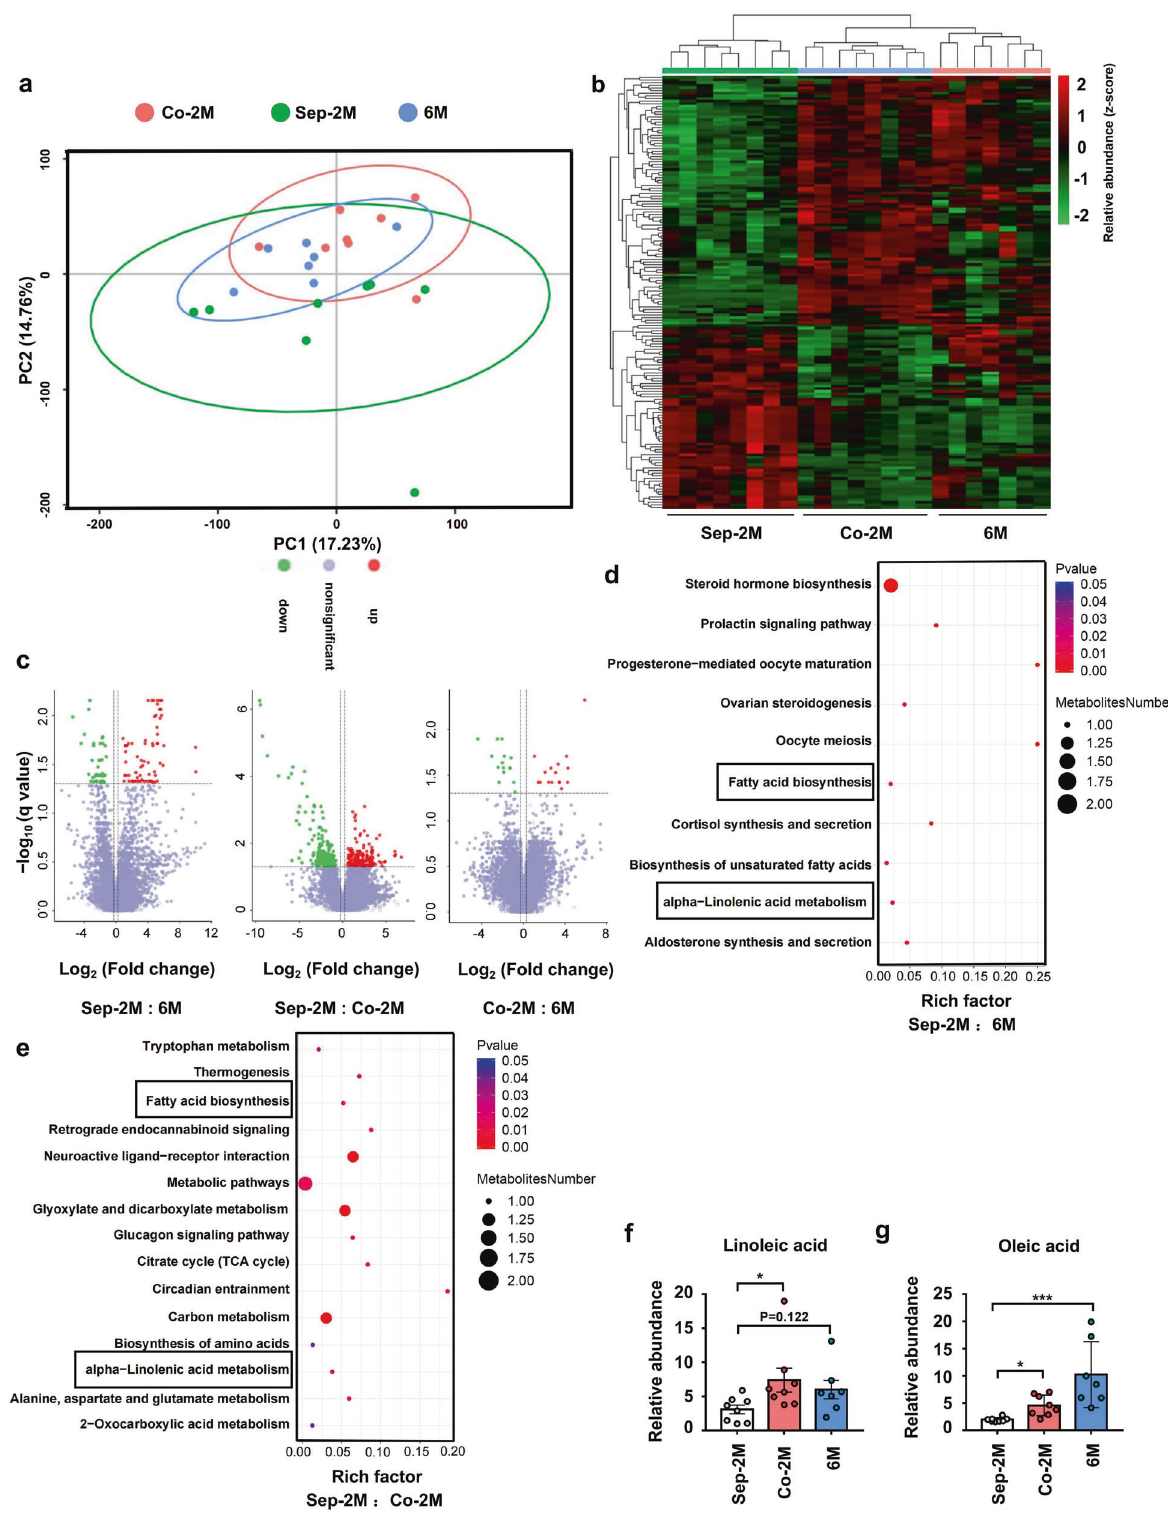
Fig. 3 Co-housing with 6 M mice changed the intestinal metabolite composition and metabolic pathways of 2 M mice. a Principal components analysis (PCA) of fecal metabolites from Sep-2M Co-2M and 6 M mice. b Heatmap of metabolites identi fi ed in fecal samples. c Volcano plot of metabolites identi fi ed in fecal samples. Volcano plots are depicted with the fold change of each metabolite and the q value was calculated by performing a t -test and corrected by the false discovery rate. d , e Pathway enrich analysis of metabolites from Sep-2M and Sep-6M mice, and Sep-2M and Co-2M mice. f , g Relative abundance of linoleic acid and oleic acid in fecal metabolites. Data presented as mean ± SD on relevant graphs. * P ≤ 0.05; ** P ≤ 0.01; *** P ≤ 0.005 (one-way ANOVA). Sep-2M ( n = 8), Co-2M ( n = 8), and 6 M ( n = 7)